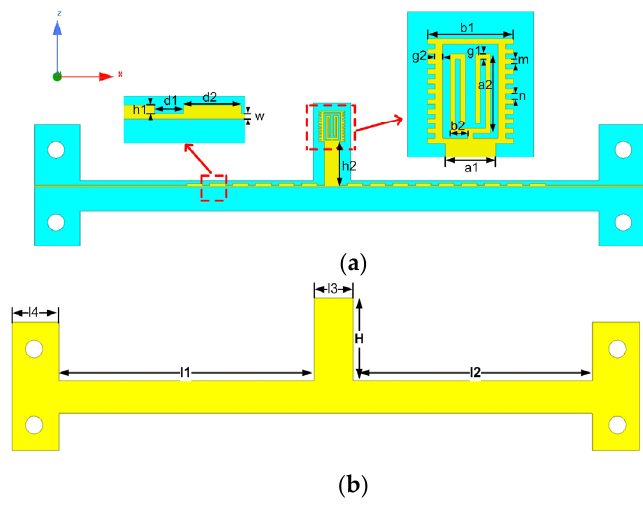
Figure 2. ( a ) Top view of sensor; ( b ) Bottom view of sensor.